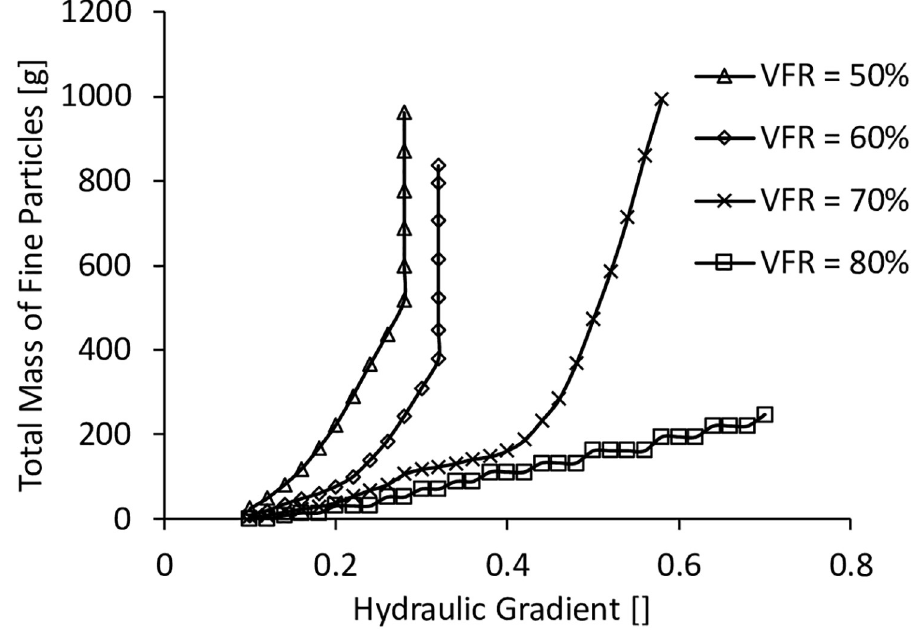
Fig 13. The accumulated total mass of fine particles in the water